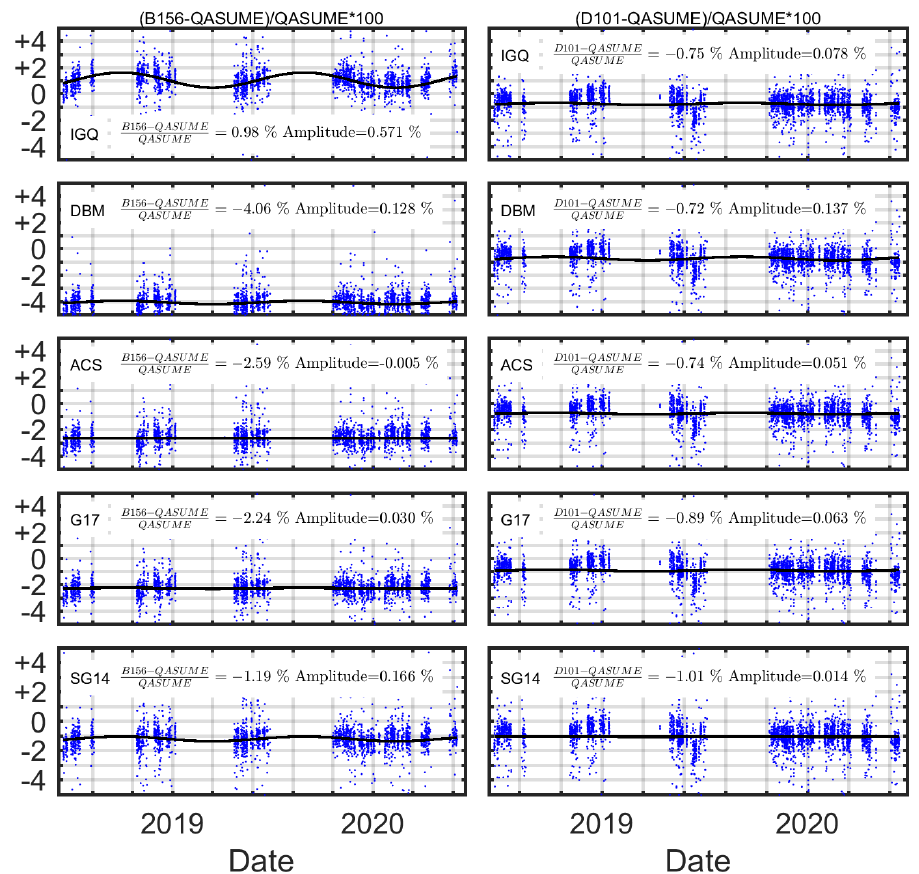
Figure 7. Comparison of TCO from Brewer 156 (left panels) and Dobson 101 (right panels) with TCO from traceable QASUME TCO retrieval for five different cross sections.